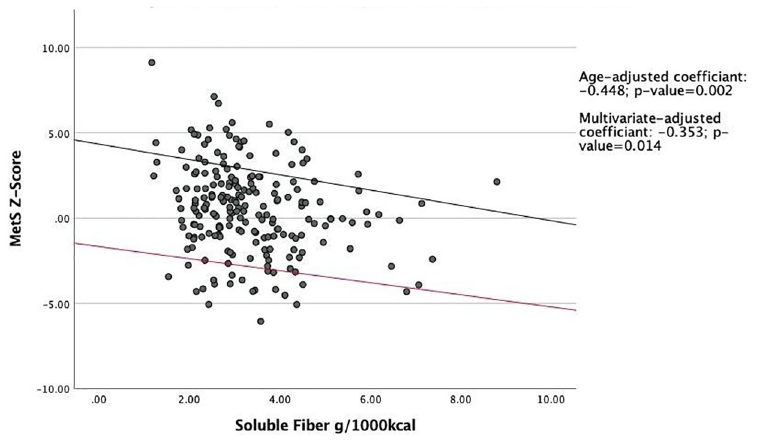
Fig 2. Association between soluble fiber intake and MetS Z-score. Abbreviations: MetS, Metabolic Syndrome. Linear regression model was used to predict association between soluble fiber intake and MetS z-score. The black regression line indicates age-adjusted linear regression, for which the coefficient is -0.448. The red line indicates multivariate- adjusted regression, for which the coefficient is -0.353. Means were adjusted for age, BMI, smoking, education, marital status, total physical activity, and total energy intake. Both lines are statistically